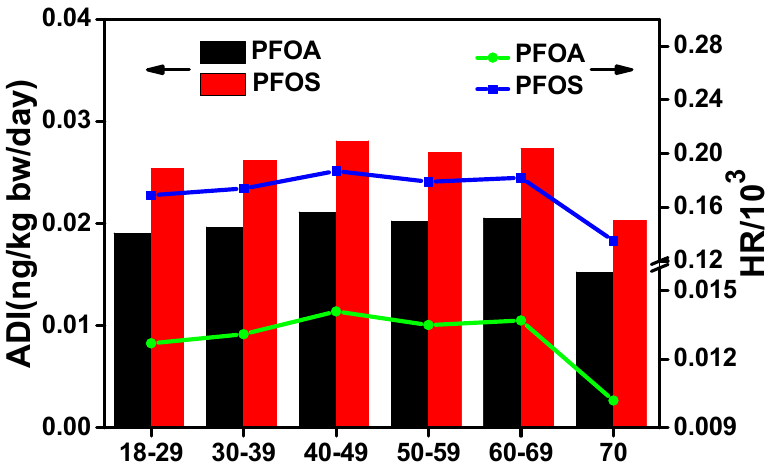
Figure 6. Average daily intake and hazard ratios of PFOS and PFOA in six age groups of Xinjiang. Int. J. Environ. Res. Public Health 2017 , 14 , 970